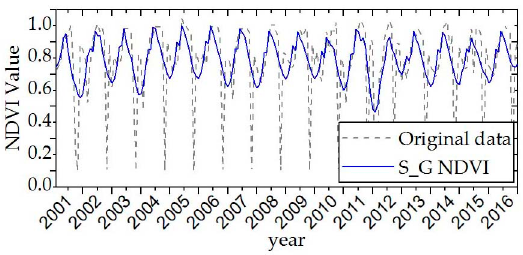
Figure 4. The minimal change in fitted values of an NDVI (Normalized Difference Vegetation Index) pixel in time series near the Huojizai Village of Maoxian County before and after the 12 May 2008 Wenchuan Earthquake. In Figures 4-6, the broken grey lines are the original MODIS-NDVI data and the solid blue lines are the fitted data.